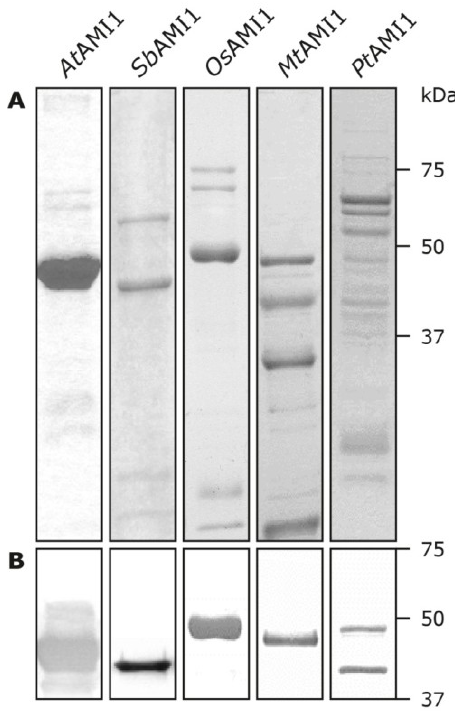
Figure 4. Expression and purification of recombinant amidases. Hexahistidine tagged amidases were expressed in E. coli and purified as described in the experimental section. Aliquots of 12.5 μL of the corresponding elution fractions were used for SDS-polyacrylamide gel electrophoresis and subsequent coomassie-staining ( A ) and immunoblotting ( B ). For the immunoblot only the region between 75 and 37 kDa is